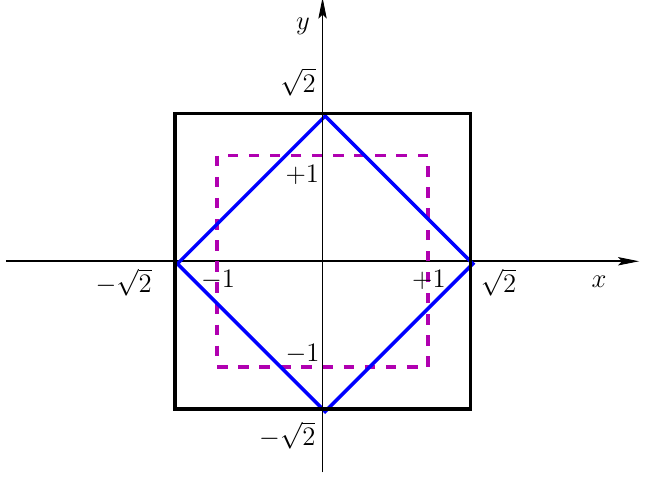
Figure 1. Wrapping